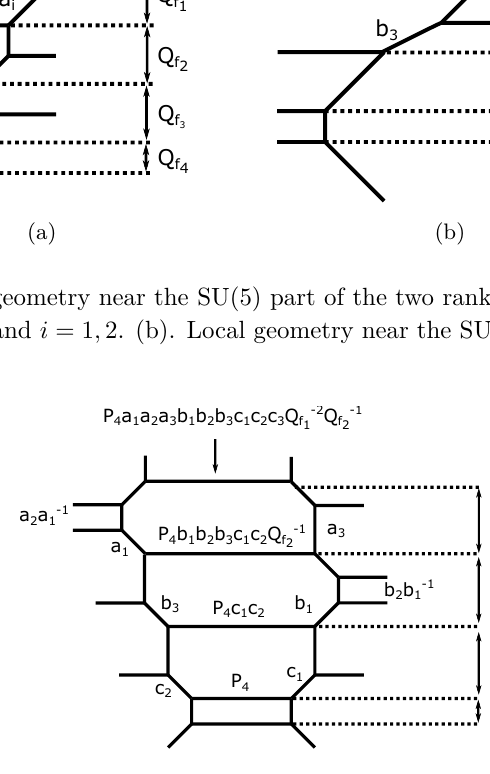
Figure 44. Local geometry for the middle SU(5) gauge node of